Question: Provide a one-line summary of what is displayed.
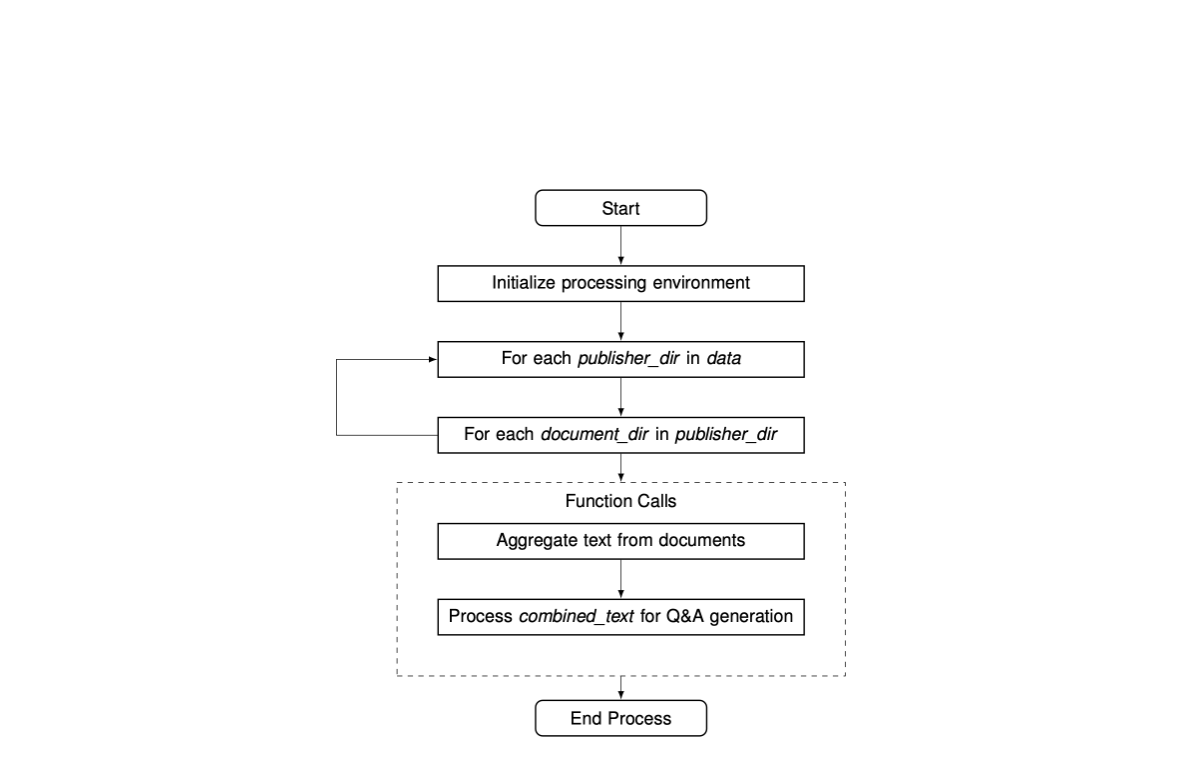
Answer: Dataset generation workflow. The figure depicts the dataset generation workflow with arrows indicating  the order in which the steps are performed. For each publisher_dir (Nature, RSC, Elsevier, ACS, AAAS, Wiley, NAS,  CCS, AIP, and APS) and every document_dir in a given publisher_dir the following function calls are made: 1.  Aggregation of text from the documents (both the MS and SI, where available) followed by processing of the  combined_text using the LLM, in this case GPT-4-Turbo, to generate the Q&A pairs. A more detailed dataset  generation workflow/algorithm is given in Figure S2.